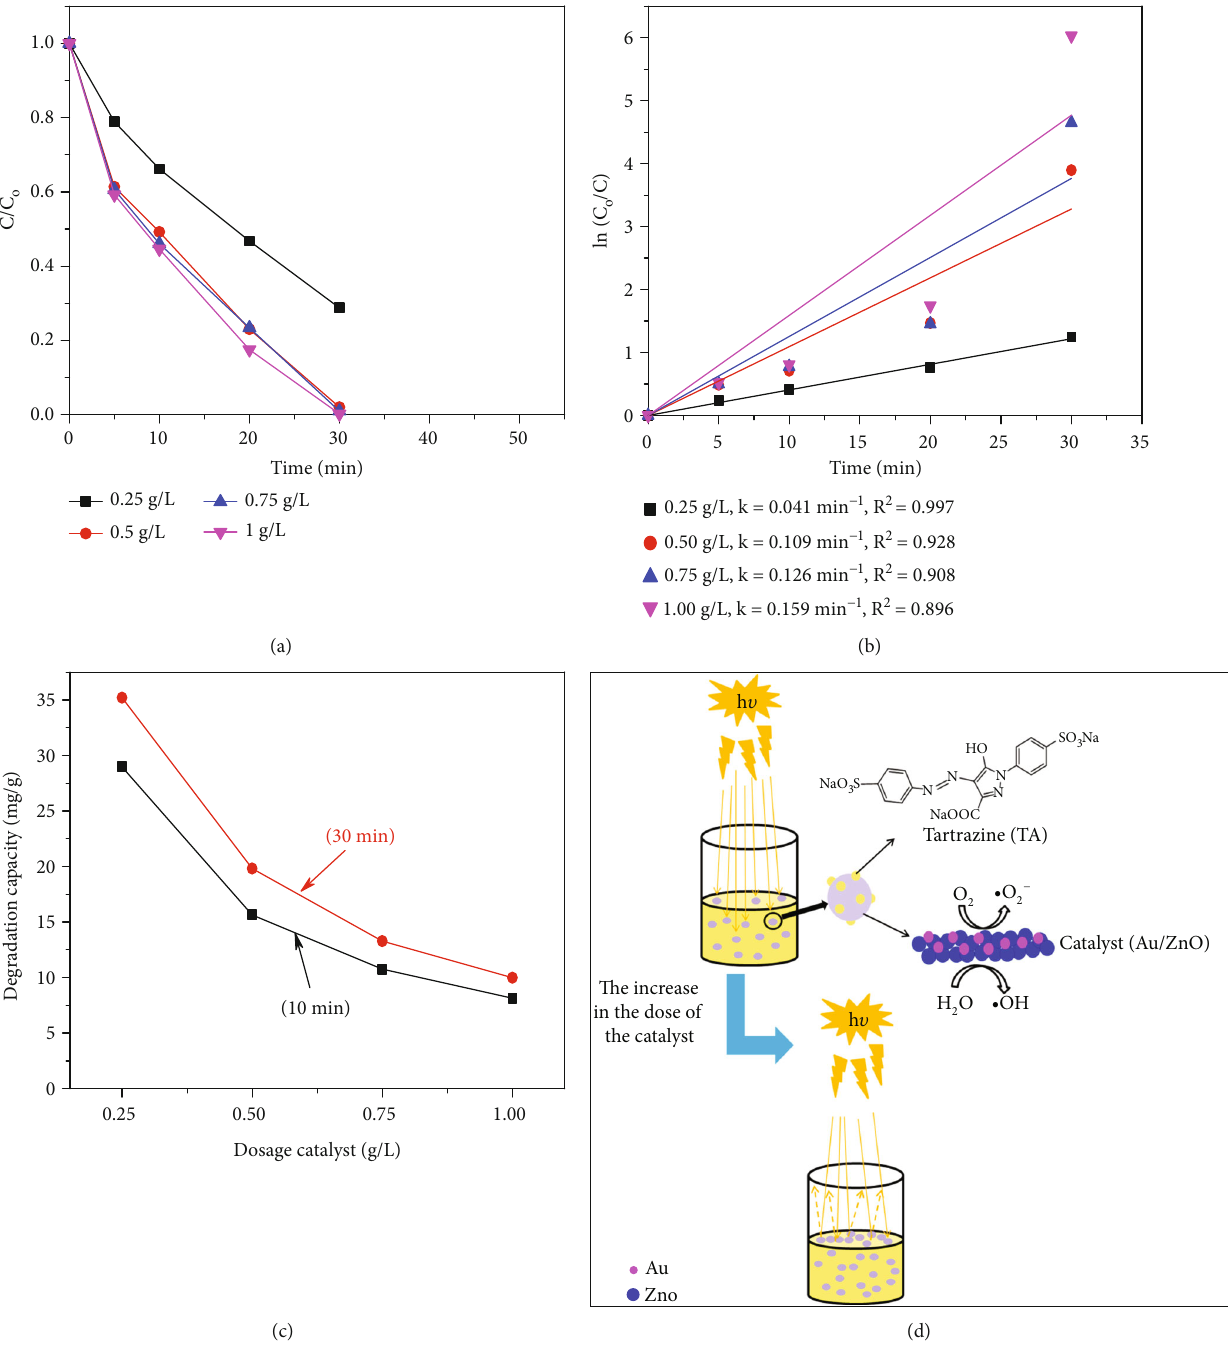
Figure 11: (a) E ff ect of catalyst dosage on degradation of TA, (b) the kinetic curves, (c) the DC versus dosage catalyst, and (d) schematic illustration of the e ff ect of catalyst dosage on degradation of TA. The reaction conditions: catalyst dosage of 0.5g/L, TA concentration of 10mg/L, and pH solution of